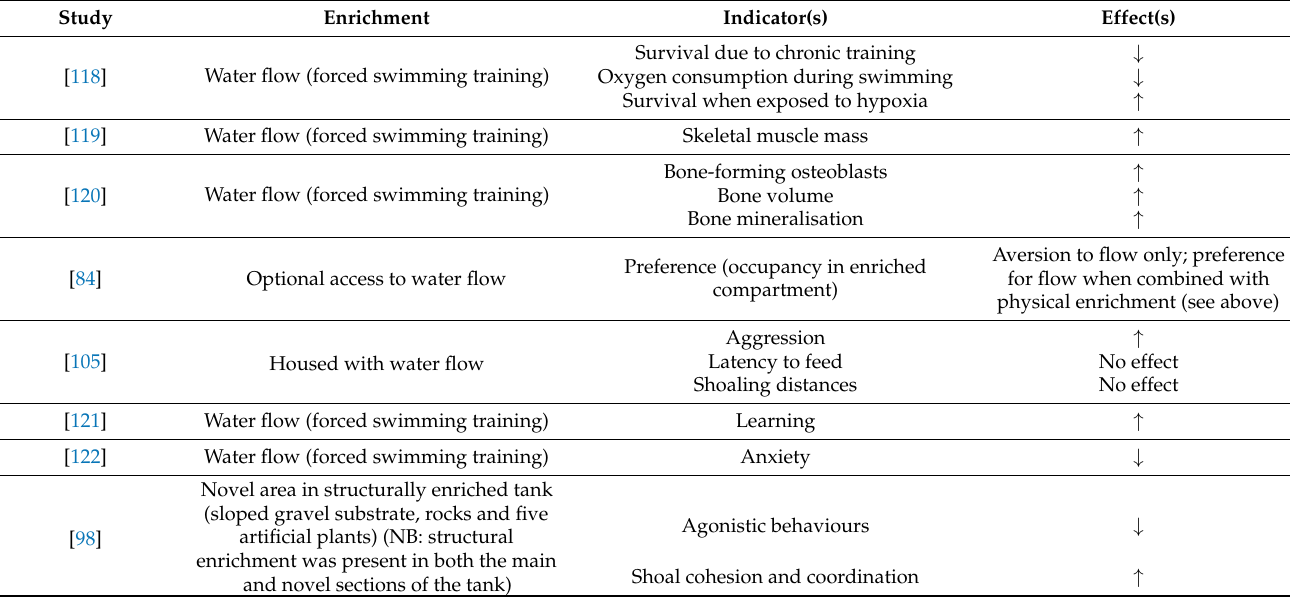
Table 3. Key results of studies relating to occupational enrichment for laboratory zebrafish. Studies have been included where they have either addressed a preference (such as might be used to identify conditions which might promote welfare), or tested the effects of a condition intended to provide enrichment. Unless otherwise specified, all results here relate to the presence of the enrichment condition noted in the table compared with an absence of that